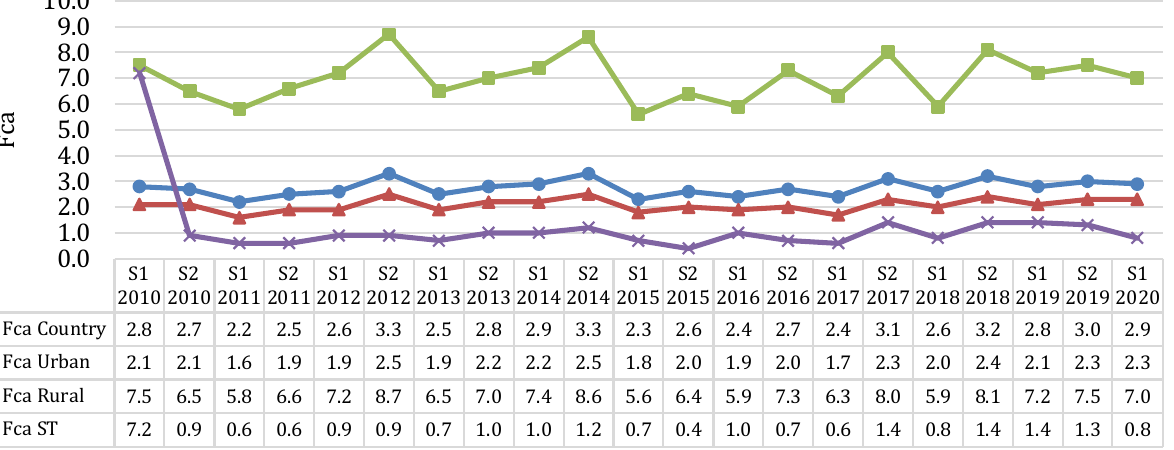
Figure 6. Semiannual Fc a from Uruguay from 2010 to 2020. In the set of results presented, the performances of Guyana, Paraguay, and Suriname were not considered, as the specifications defined in Section 3 were not found. In addi- tion, relevant databases were not found for Bolivia and Venezuela, relating to established indicators and/or information on reimbursements to customers for violating service qual- ity limits.